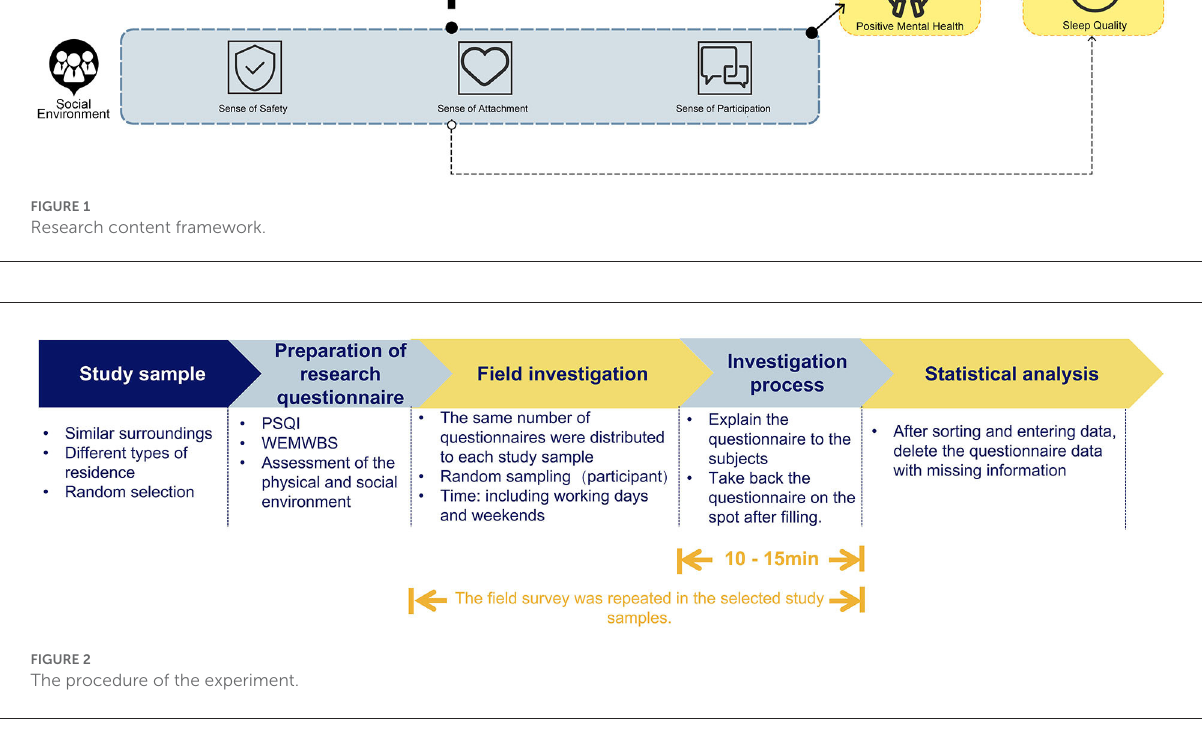
TABLE 1 Residential physical environment and social environment